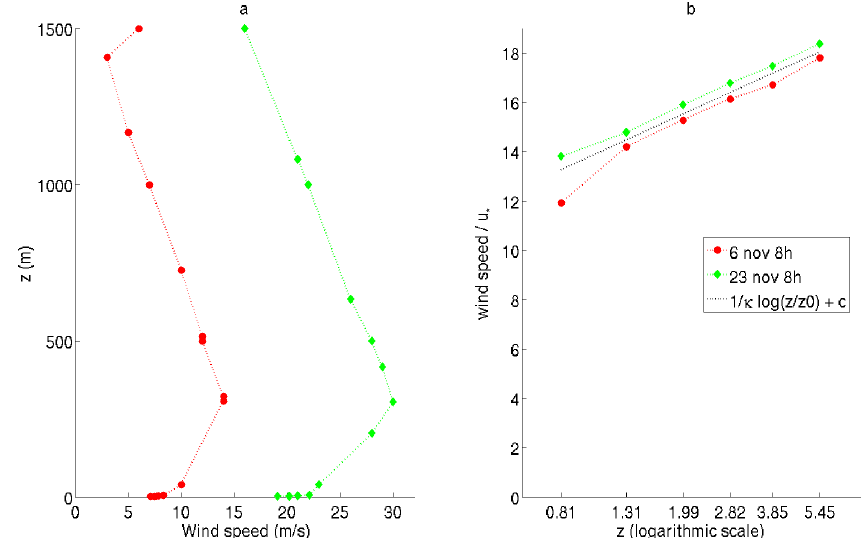
Figure 10. (a) Wind velocity profile from radiosounding performed at 08:00LT (local time) on 6 and 23 November. (b) Normalized wind profile on a semi-log plot, from the 7m mast data at 08:00LT on 6 and 23 November.